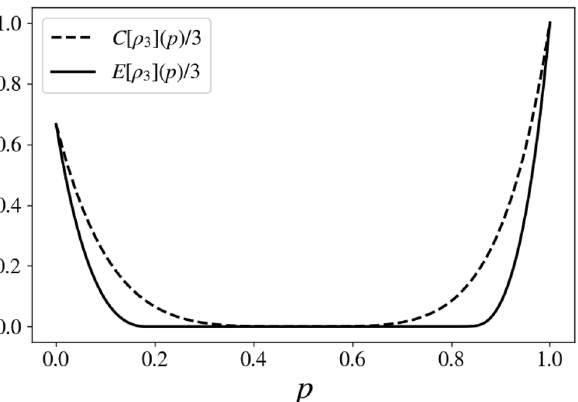
ρ 3 ( p )/ 3 (continuous line) versus p for state (23). It is clear that the [ ]